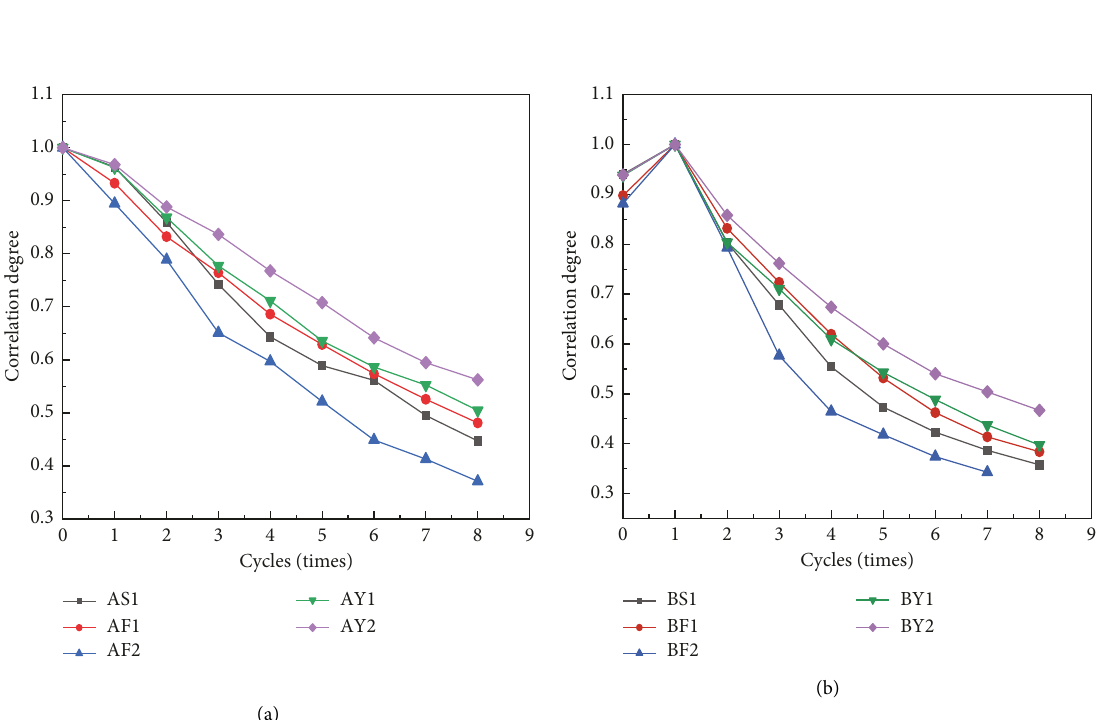
Figure 5: The change process of the correlation values of each test group. (a) Water. (b) Compound salt